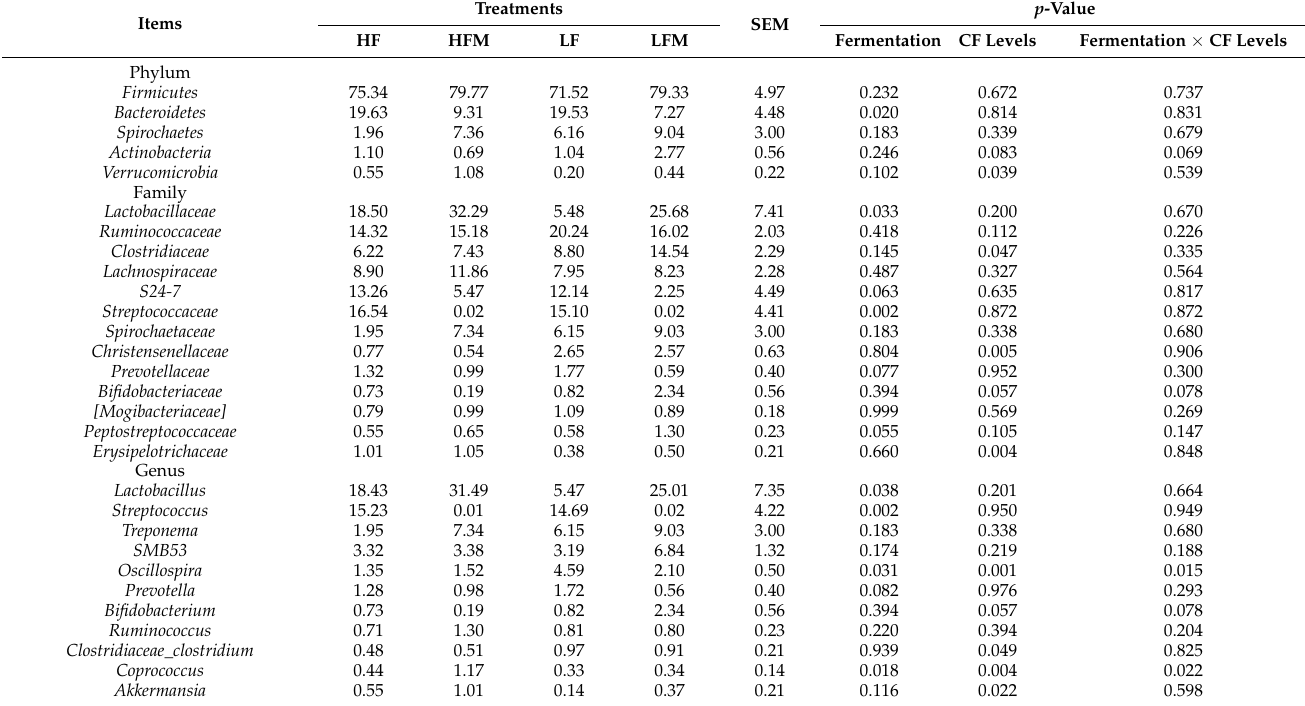
Table 6. Effects of multi-bacteria fermentation and dietary CF level on the relative abundance of rectal microorganisms